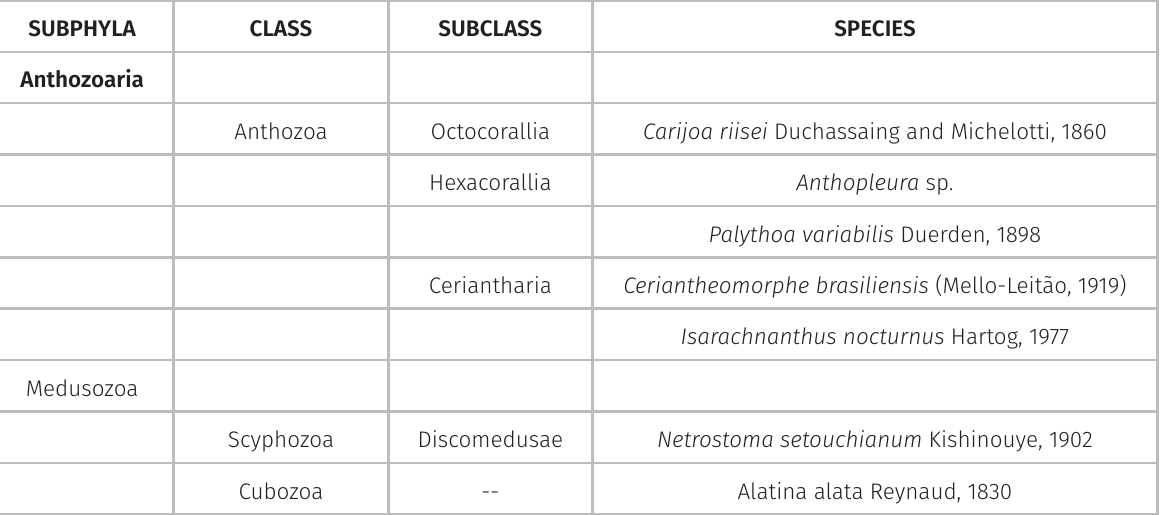
Table I. List of species observed in this